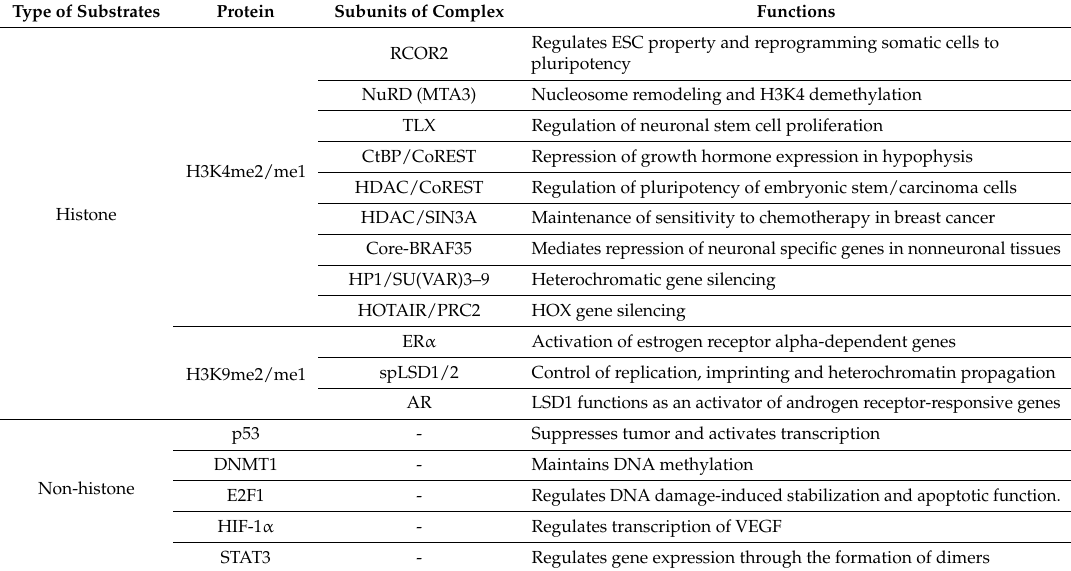
Table 1. LSD1 substrates and regulatory